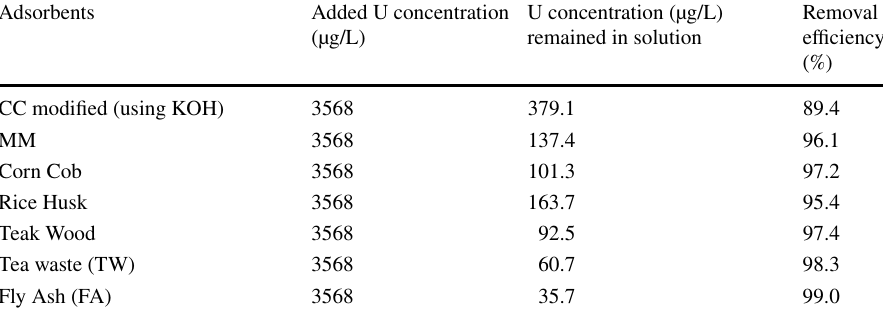
remained in supernatant after adsorption process